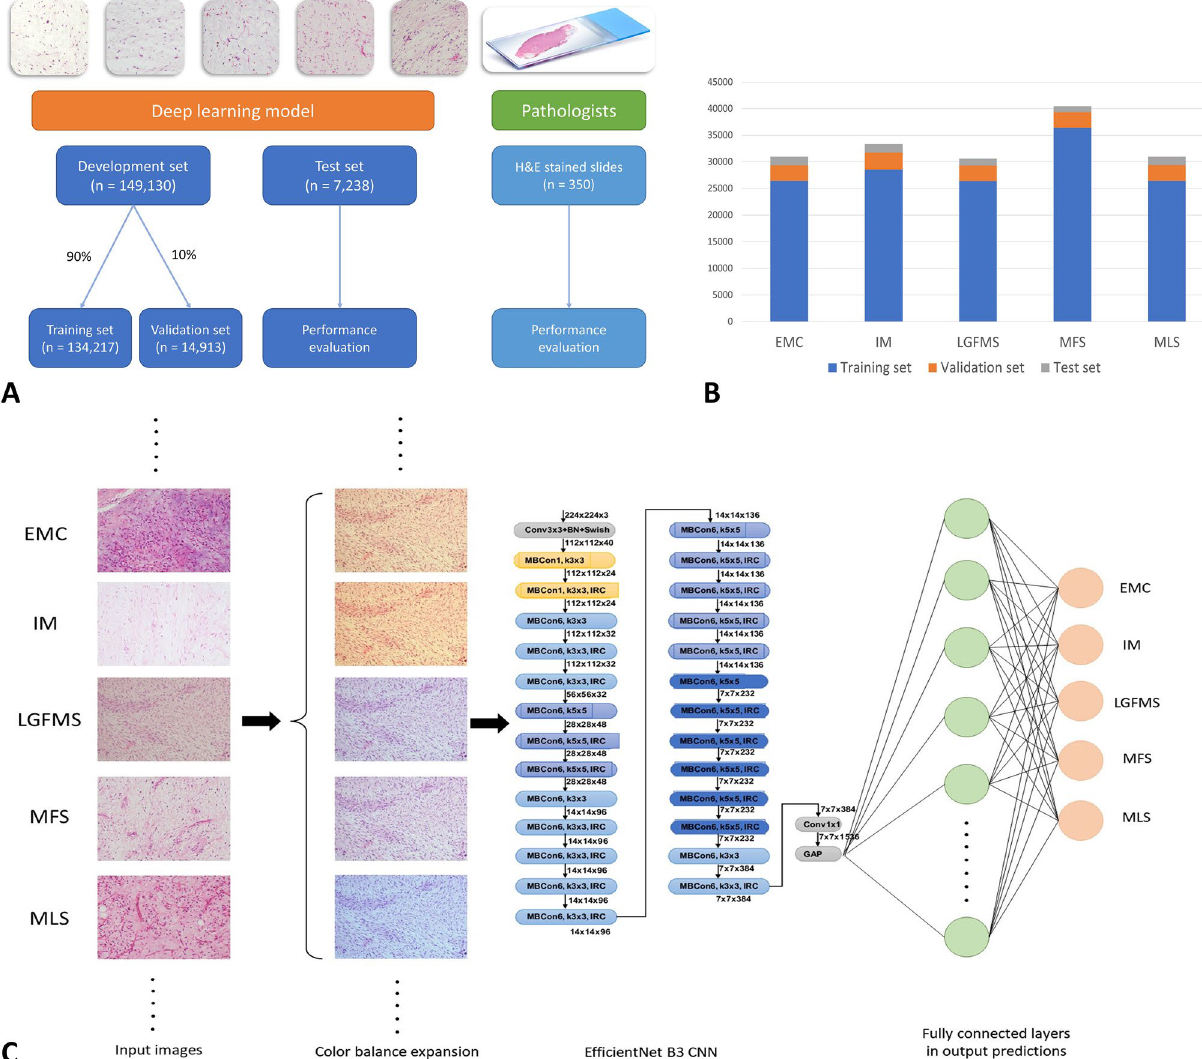
Figure 2. Overview of strategies of training the deep learning models in comparison with pathologists ( A ). Number of images in different diagnostic categories of different datasets ( B ). Schematic diagram depicting the training workflow of AI model ( C ). EMC extraskeletal myxoid chondrosarcoma, IM intramuscular myxoma, LGFMS low grade fibromyxoid sarcoma, MFS myxofibrosarcoma, MLS myxoid